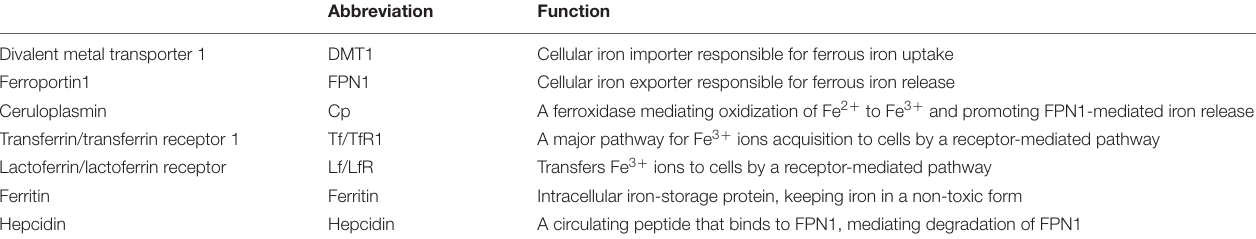
TABLE 1 | A list of abbreviations and the functions of iron related proteins.